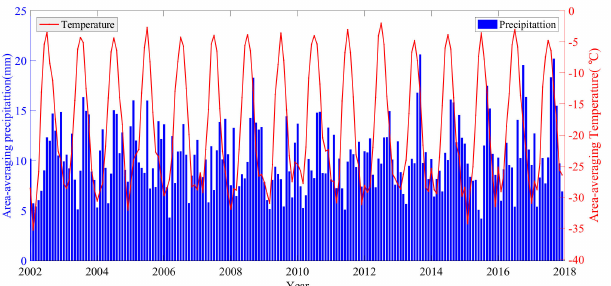
Figure 11. Time series of the mean surface temperature and the area-averaged precipitation during 2002–2016 (temperature unit: ◦ C, precipitation unit: